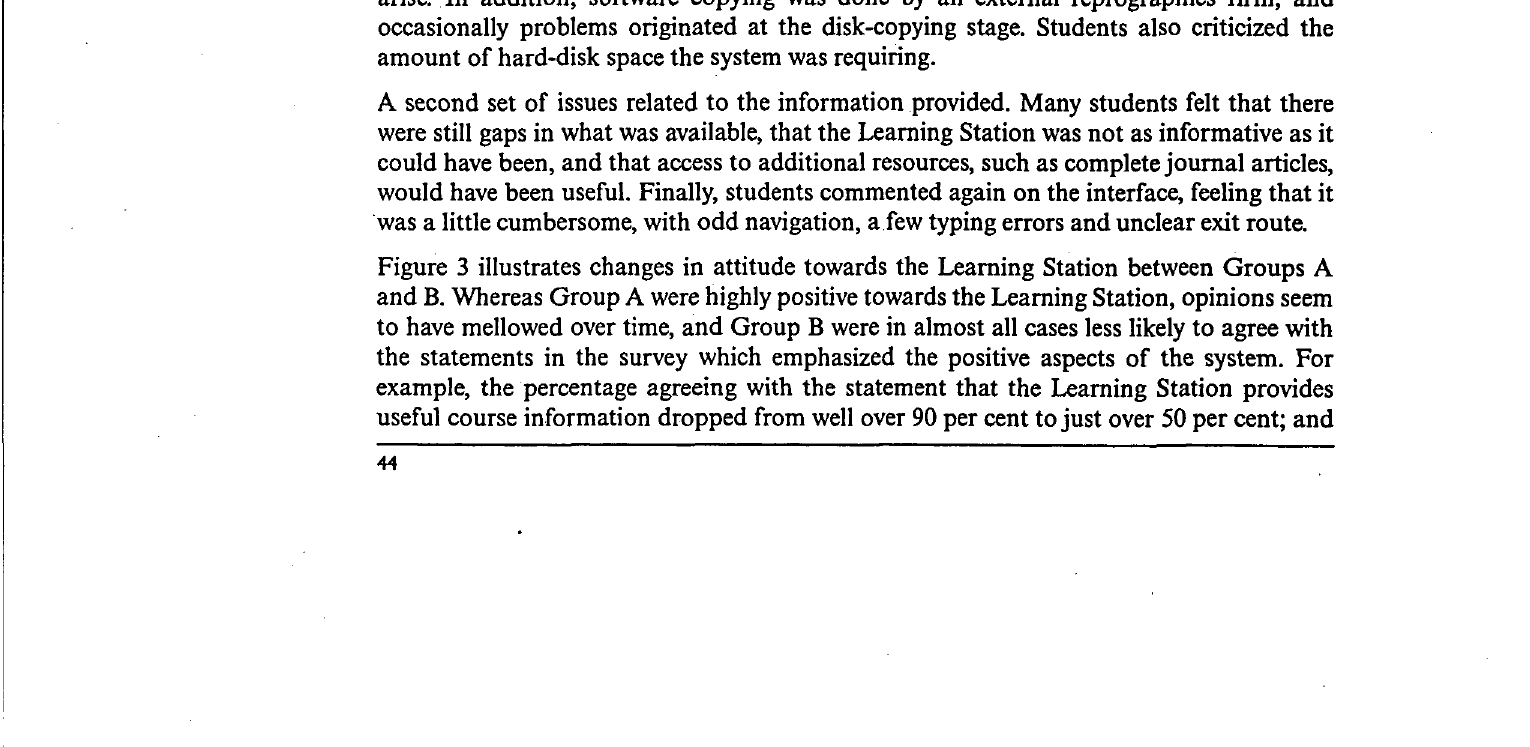
8 is time-consuming and frustrating 9 provides useful course